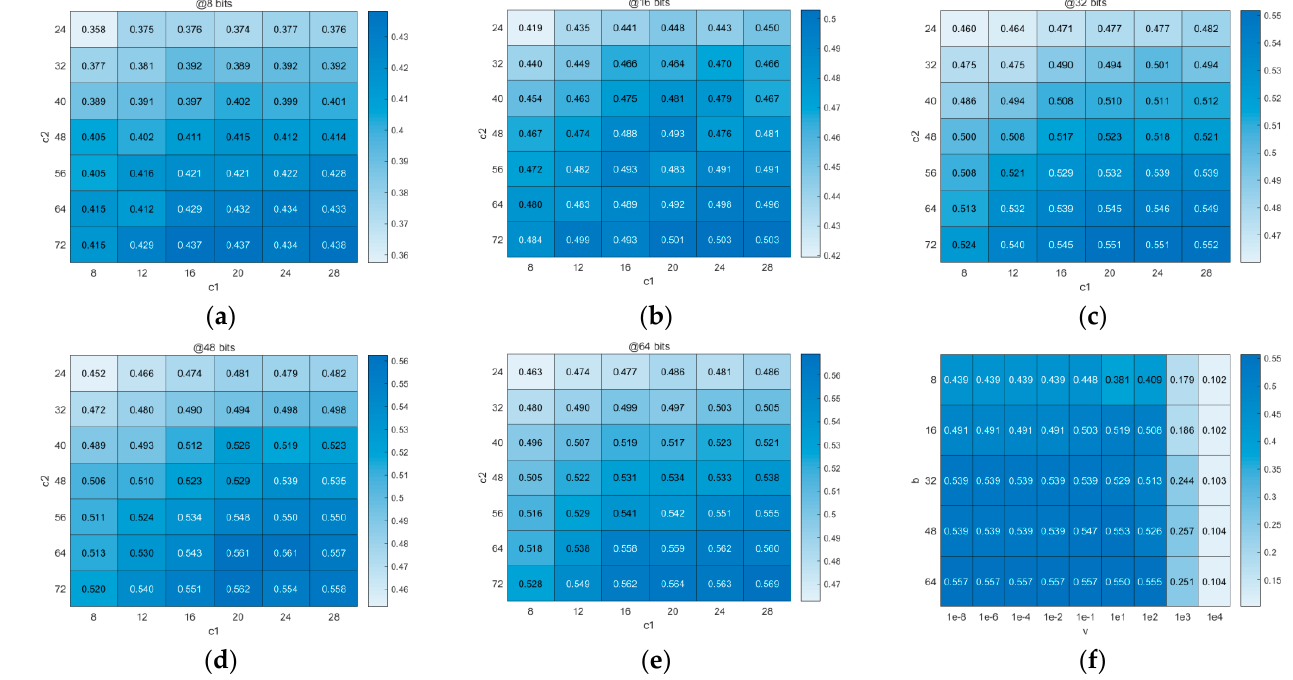
Figure 11. The heatmap of parameter selection experiments on the CIFAR-10 database. The MAP changes with c 1 and c 2 when: ( a ) hash bits equal 8; ( b ) hash bits equal 16; ( c ) hash bits equal 32; ( d ) hash bits equal 48; ( e ) hash bits equal 64. ( f ) The MAP changes with ν on different hash bits.